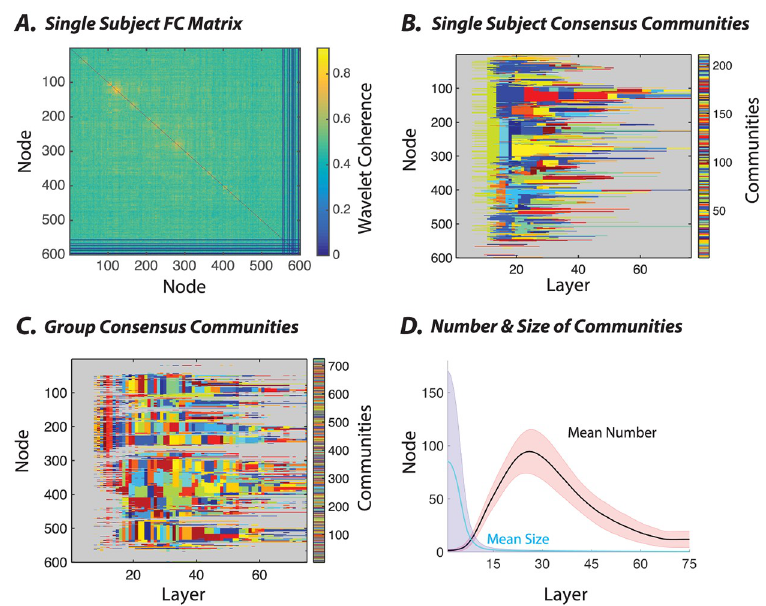
Fig 4. Application of multi-scale community detection to subject-level and group-level resting state functional brain networks. (A) An example rsfMRI connectivity matrix from one subject, in which each element linking a pair of brain regions represents the pairwise wavelet coherence between regional time series. (B) The consensus partition representing the multi-scale community structure for the matrix in panel (A) . To enhance the visual detection of the communities, we have represented all singleton communities with the same gray color. (C) The consensus partition representing the multi-scale community structure for the group-level functional matrix, which is defined as the average connectivity matrix across participants. Here, again, to enhance clarity, we color the singleton communities in the same gray color. (D) The average number (out of 600 total nodes) as well as the average size (expressed as the percentage of total nodes) of non-singleton communities calculated across layers, which in our case track γ increments. In these analyses, we used a structural resolution parameter γ 2 [0.95, 1.7], an inter-layer γ increment of 0.01, and 75